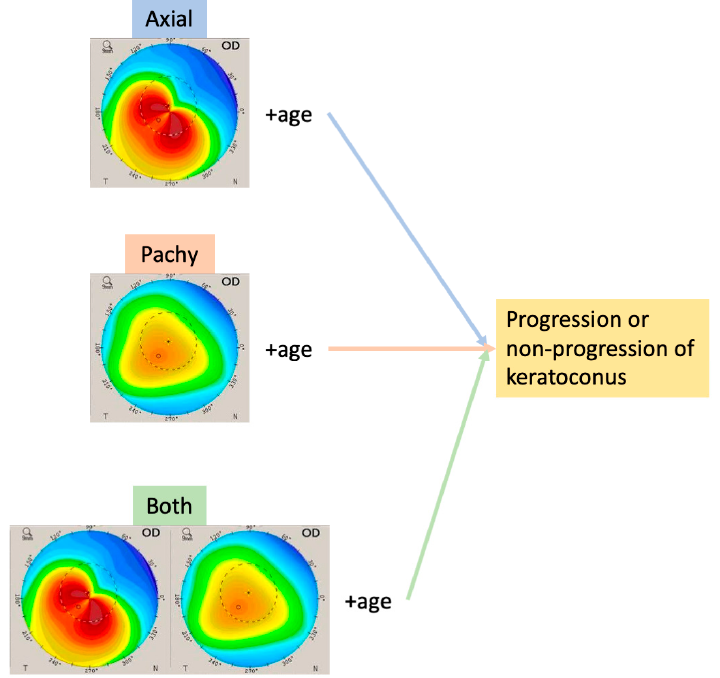
Figure 2. Conical cornea progression prediction using a combined axial map, pachymetry, and a combined image of the two, with respect to patients’ age.